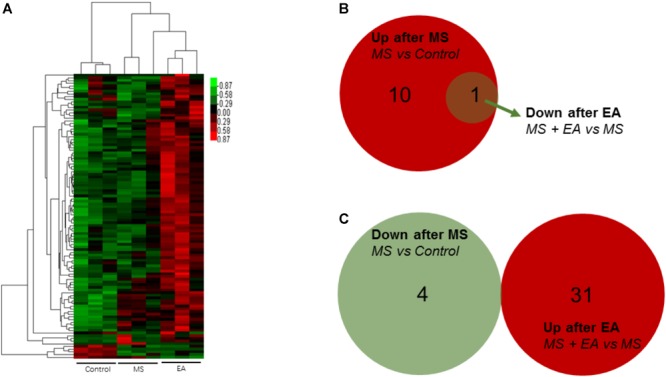
Differential lncRNA expression in the prefrontal cortex of Cont, MS, and MS+EA in adult rats. (A) Heatmap of differentially expressed lncRNAs between Cont, MS, and MS+EA samples (p < 0.05) with green and red spectrum colors indicating downregulated and upregulated expression, respectively. (B,C) Venn diagrams show overlaps of differentially expressed lncRNAs between experimental groups. One gene increased expression in MS group but decreased in EA group. No genes decreased expression in MS group but increased in EA group.